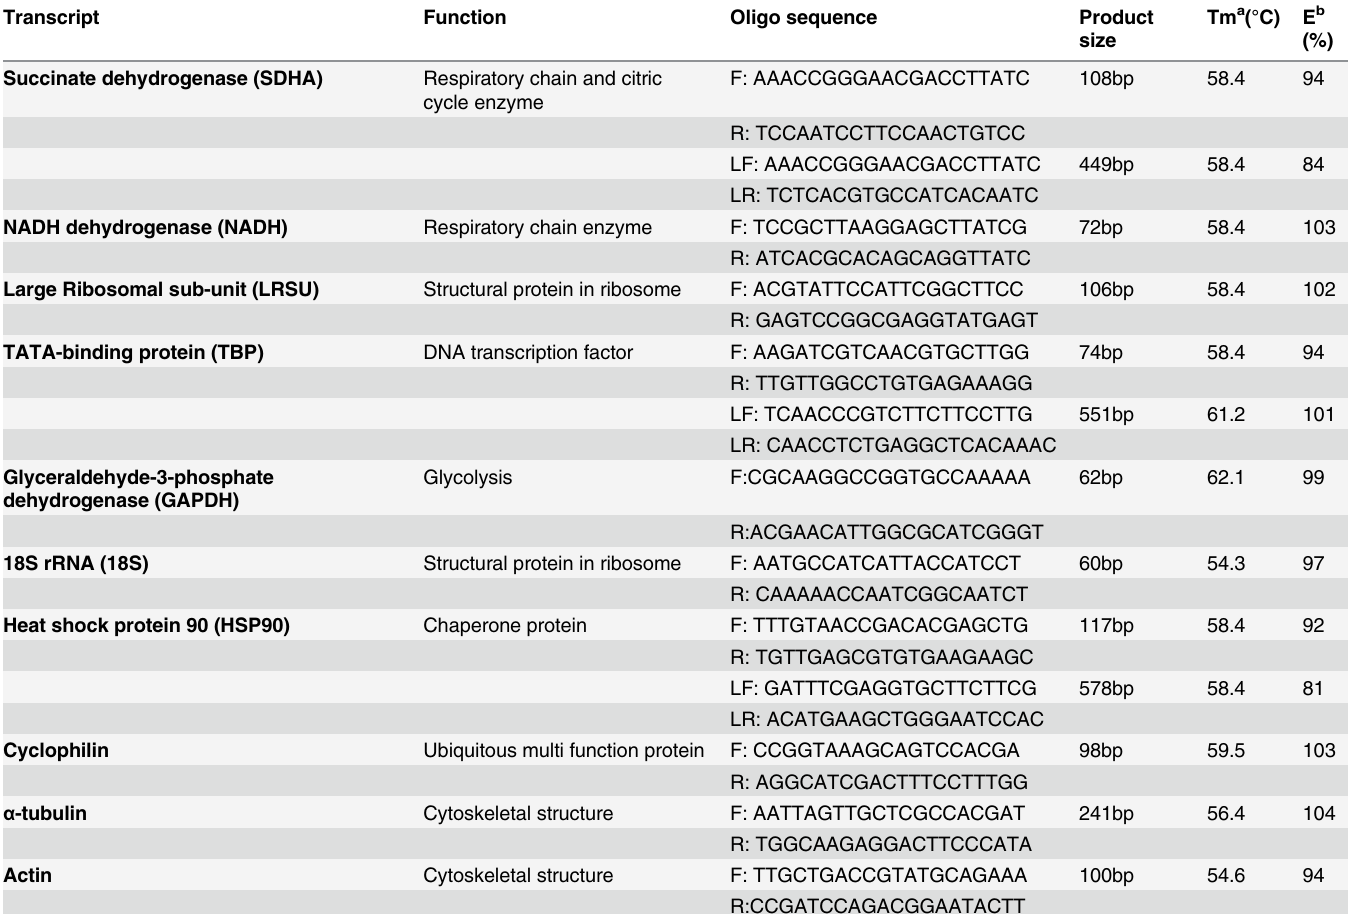
Table 1. Candidate reference genes selected for stability